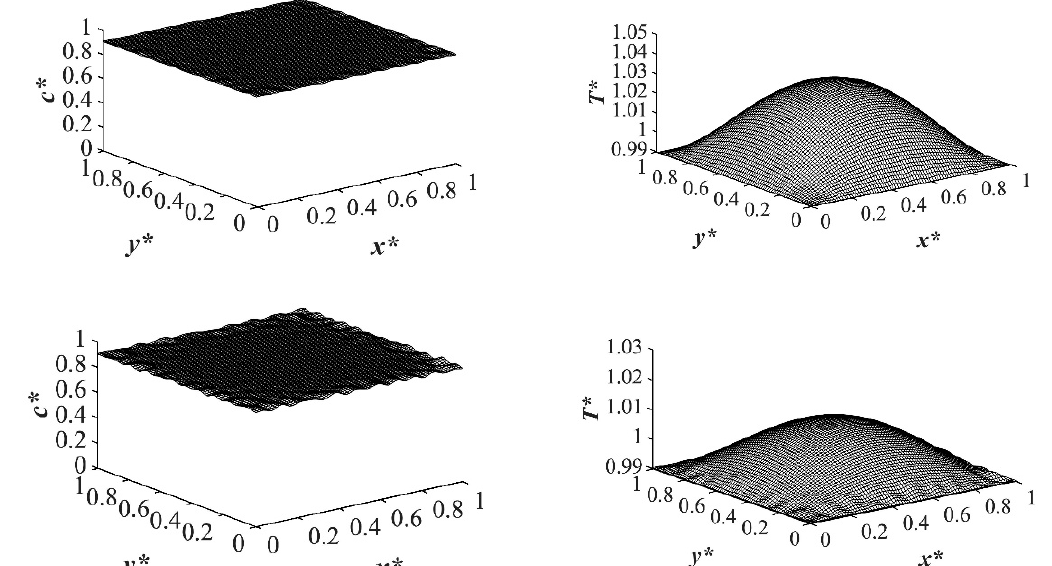
Figure 12. The influence of initial solution temperature on phase separation through TIPS process with two different dimensionless initial solution temperatures of ( a ) T * = 1.05 and ( b ) T * = 1.03 to the same quench temperature of T * q2 = 0.99 at time t * = 1.03 × 10 − 5 . As time proceeded and phase separation progressed inside the sample at t * = 5.03